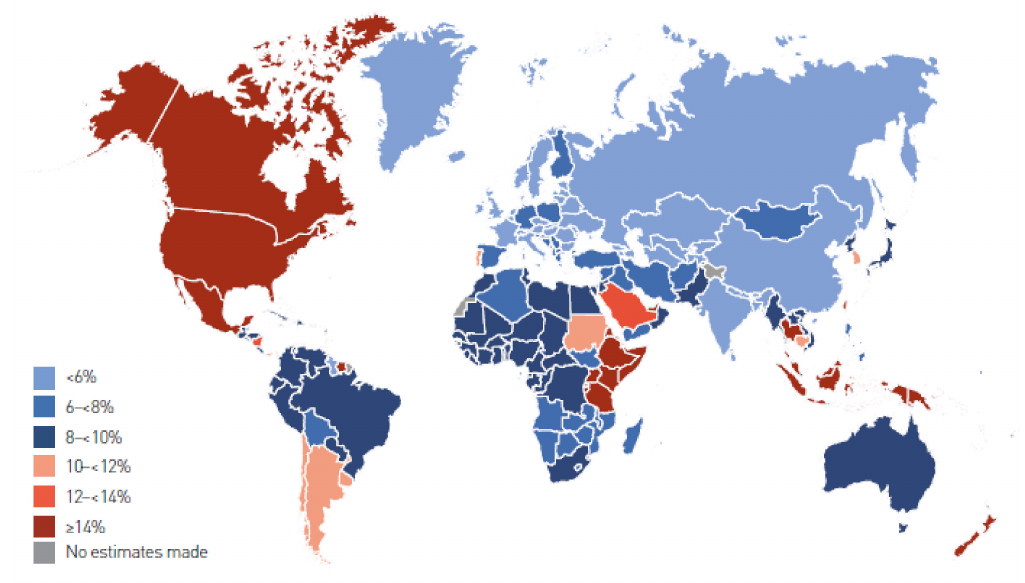
Figure 1. Age-adjusted comparative prevalence of impaired glucose tolerance in adults (20–79 years) in 2019, adapted from International Diabetes Federation. IDF Diabetes Atlas, 9th edn. Brussels, Belgium